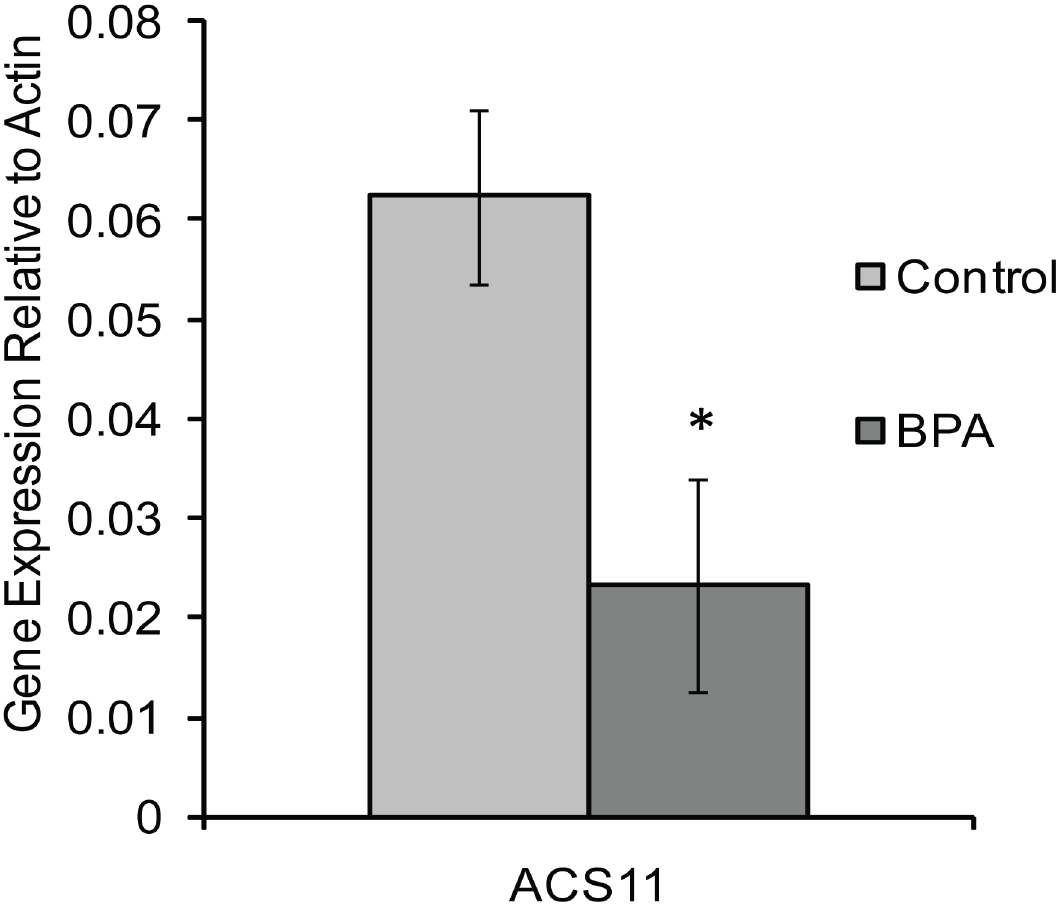
Fig 1. BPA changes gene expression of ACS11 . The hormone responsive gene ACS11 shows decreased gene expression upon treatment with 200nM BPA once daily for 28 days. Bar represents average of three technical replicates from pooled data of 20 pots of plants. Error bars represent standard error. * indicates p-values < 0.05 when compared to 0nM BPA plants.